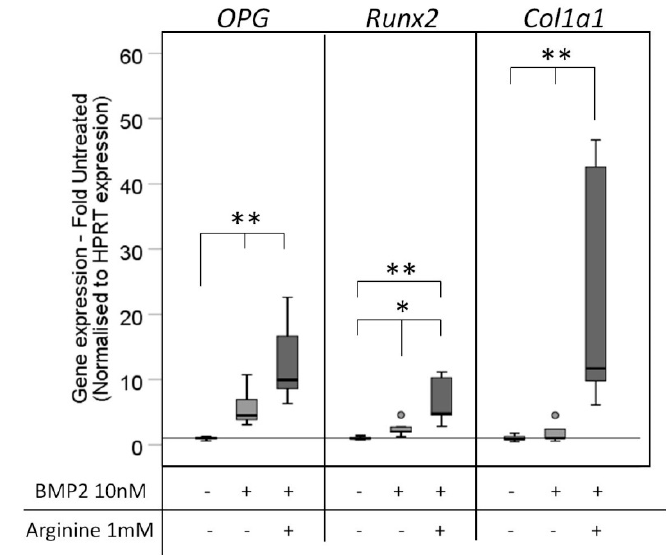
Figure 6. Osteogenic gene expression after stimulation with the NOS substrate Arginine. C2C12BRELuc cells were stimulated for six days in Arginine-free DMEM with 10 nM BMP2 alone or in combination with 1 mM Arginine. The gene expression of OPG, Runx2 , and Col1a1 was investigated by qRT-PCR. Statistics: Kruskal–Wallis Test followed by Mann-Whitney U test. Mann-Whitney U test significances between samples were assigned if p < 0.05 (*) or p < 0.01 (**). Circles are outlying values. Number of replications: n = 6.